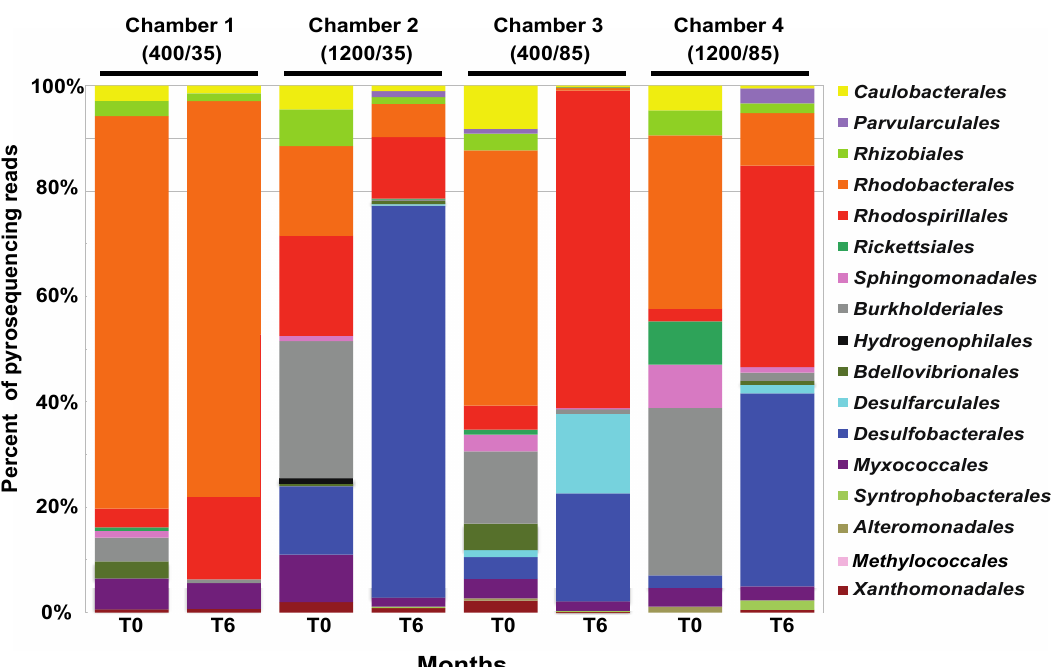
Figure 4. Comparisons of dominant proteobacterial lineages based on OTU analyses in microbialite treatments at 0 (T0) and 6 (T6) months. The histograms represent the percent of classified sequences that could be assigned to an order by a Bayesian approach at a confidence interval ≥ 70% against the SILVA SSU REF v102 database. The environmental parameters within each environmental chamber are listed in parentheses and include the CO and salinity levels, 2